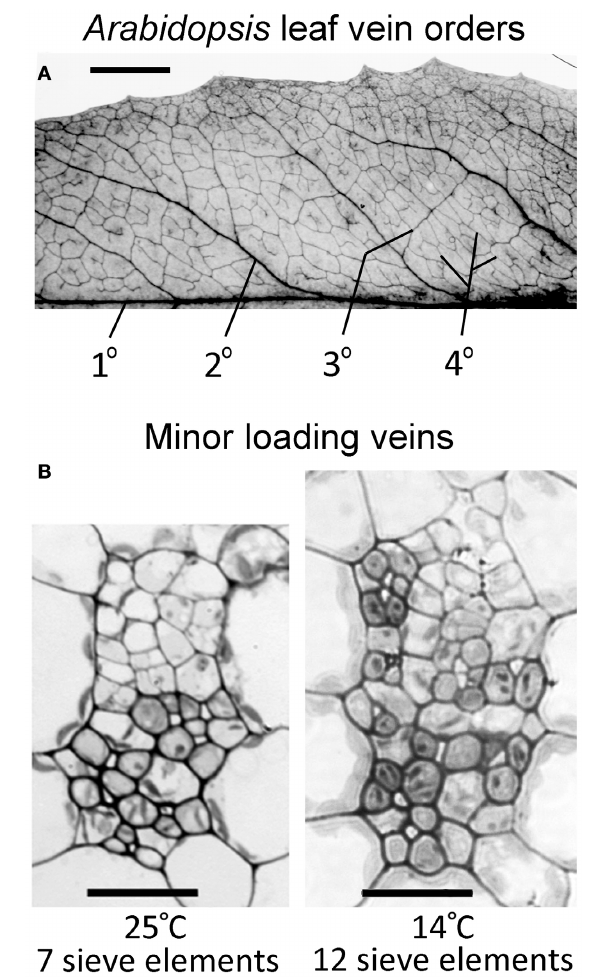
FIGURE 2 | (A) Vein orders in a cleared A. thaliana leaf (Swedish ecotype) grown at 25 ◦ C, with first order (1 ◦ ) being the midrib and second-order veins (2 ◦ ) comprised of main vascular branches off the midrib (typically five per leaf side, with five shown here either as portions or in their entirety), as defined by Hickey (1973). Third-order veins (3 ◦ ) branch off the second order veins, and fourth-order veins (4 ◦ ) are the smallest and can branch off all vein orders. ( B ) Cross-sectional light microscopic images are representative of fourth-order veins from mature leaves grown in warm (25 ◦ C) or cool (14 ◦ C) conditions under moderate light (400 µ mol photons m − 2 s − 1 ). The vein shown from the plant grown at 25 ◦ C ( B , left panel) contains seven sieve elements in the lower (abaxial) phloem region of the vein and features phloem parenchyma (angular and light colored) and companion cells (rounded and dark colored). The vein shown from the plant grown at 14 ◦ C ( B , right panel) contains 12 sieve elements and features associated phloem cells encroaching into the upper (adaxial) region occupied by xylem cells. Scale bars shown are 5mm for vein pattern and order ( A ) and 20 µ m for fourth-order veins ( B , same scale for both panels). The Italian and Col-0 ecotypes exhibited the same venation pattern and similar vein cross-sectional ultrastructure as shown here for the Swedish